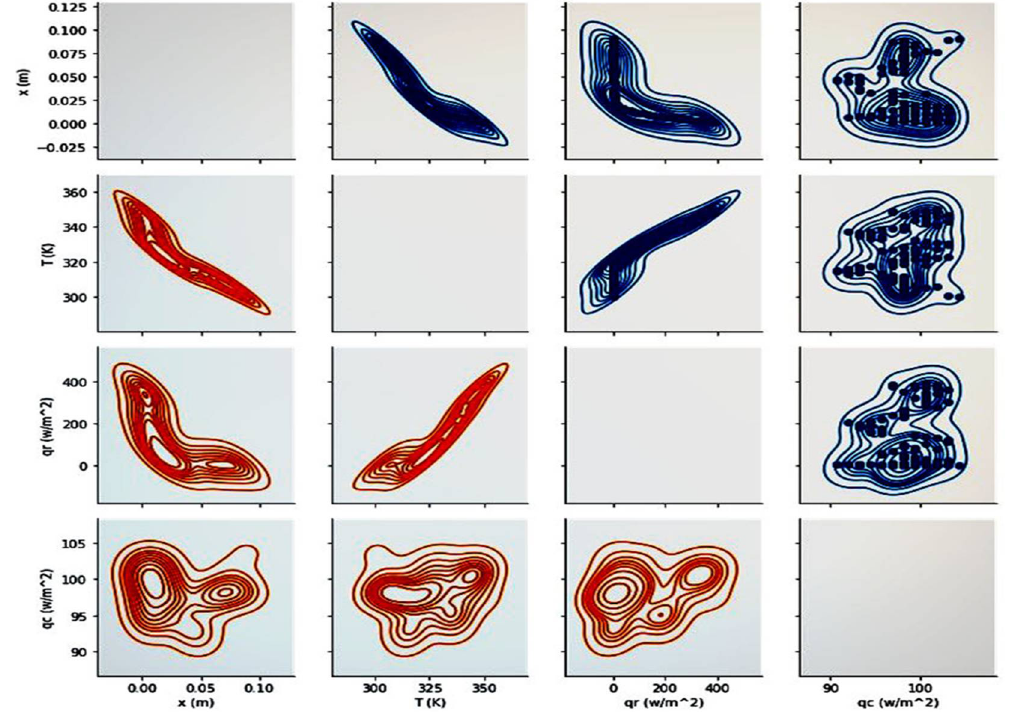
Figure 9. The overall figures of different parameters’ correlations.